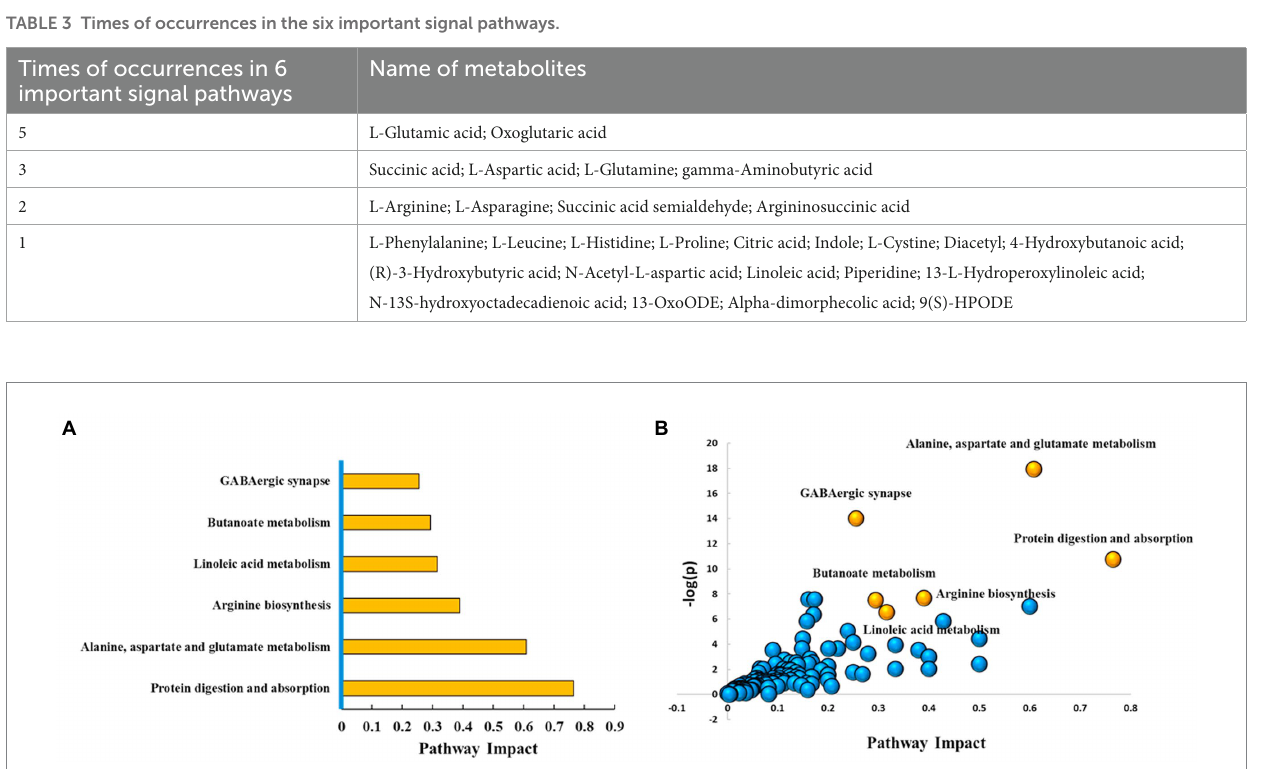
FIGURE 3 Top six metabolic pathways. (A) Histogram of top six metabolic pathways. (B) Bubble diagram of metabolic pathways. Each bubble represents a metabolic pathway. The top six pathways were highlighted in yellow color, and the rest remaining were in blue color. Based on the significant values of value of p, pathway impact score, and FDR (<0.05, >0.2, and < 0.05, respectively), the top six metabolic pathways were selected and shown by name. Ctrl: control group; AD: alcohol dependence